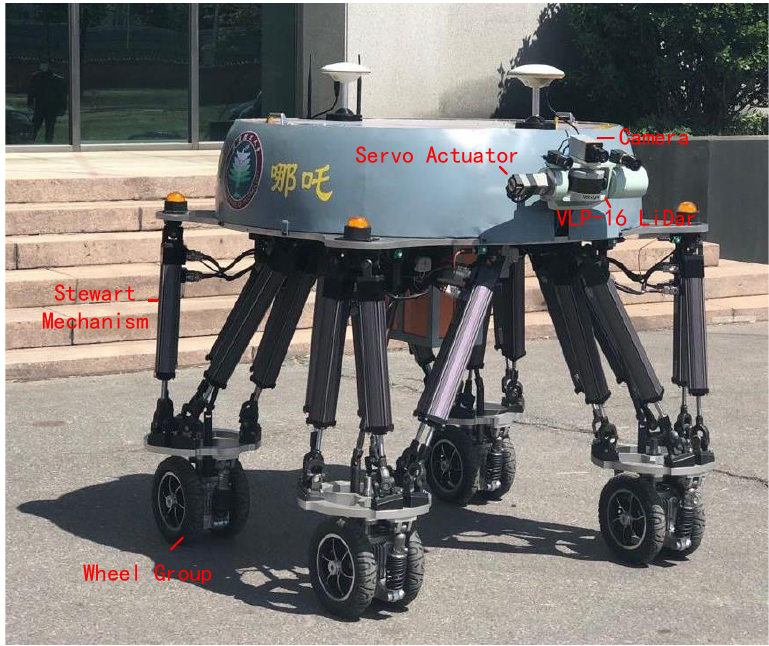
Figure 1. The physical prototype of BIT-NAZA